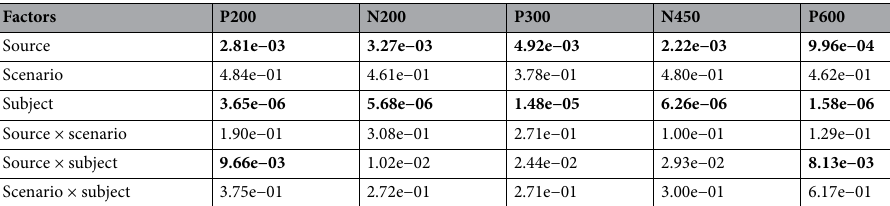
Table 1. Results of the ANOVA test on the effect of the factors of the experiment (source: interface or agent, scenario: SW or SR, and the subjects) and their interaction on the average absolute Anterior Cingulate Cortex (ACC) activation around the peaks of the ErrP components. Statistically significant values are in